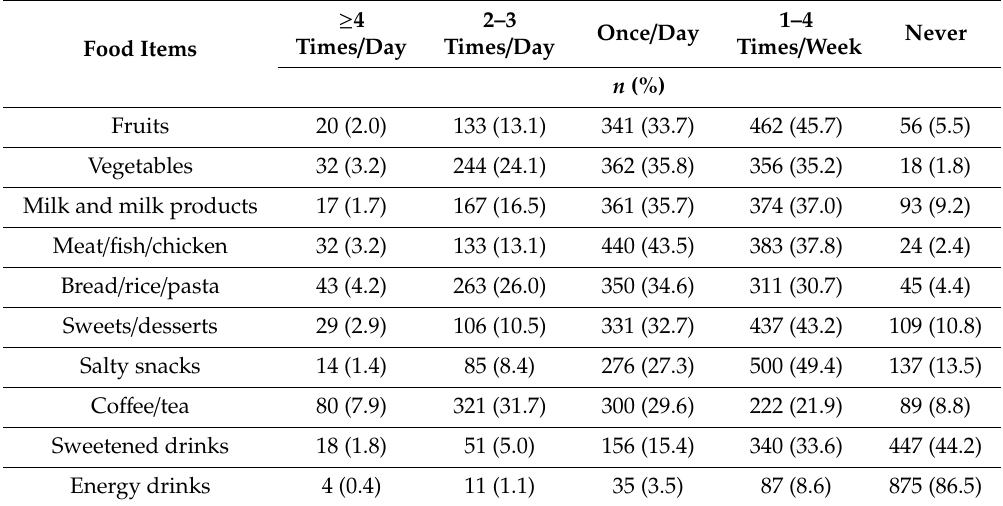
Table 4. The frequency of consumption of particular foods during COVID-19 pandemic ( n =